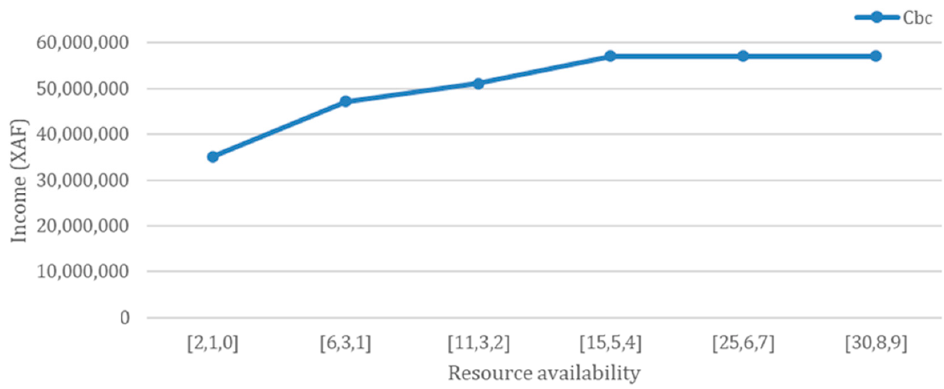
Figure 7. Variation of income according to the availability of resources.